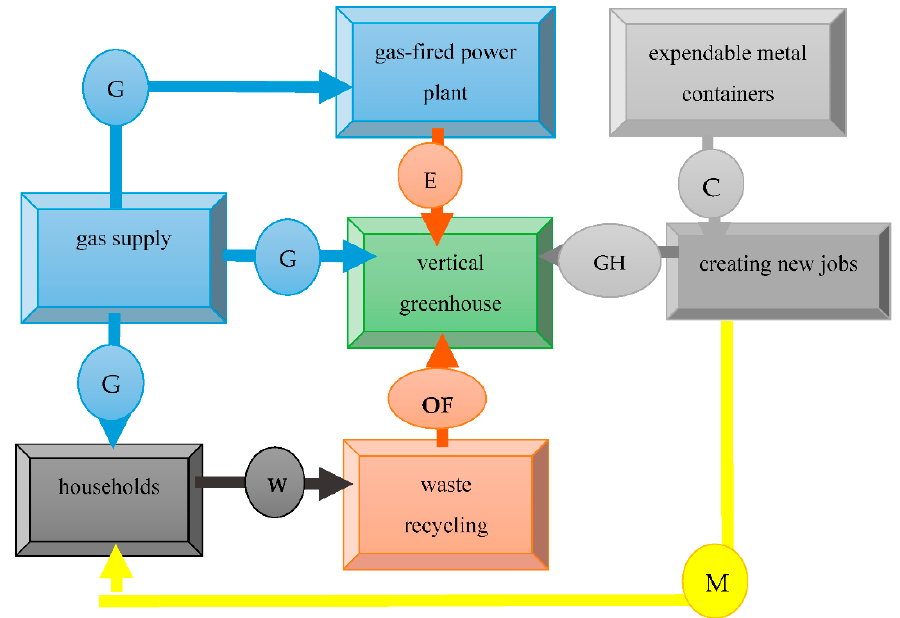
Figure 6. Vertical greenhouses are the solution to the problem of food security and a fragment of the food chain of the circular economy. Legend: G is natural gas; E is electric power; C is sea containers; GH is greenhouse module; OF is organic fertilizer; W is waste; M is money. Source: designed by authors.